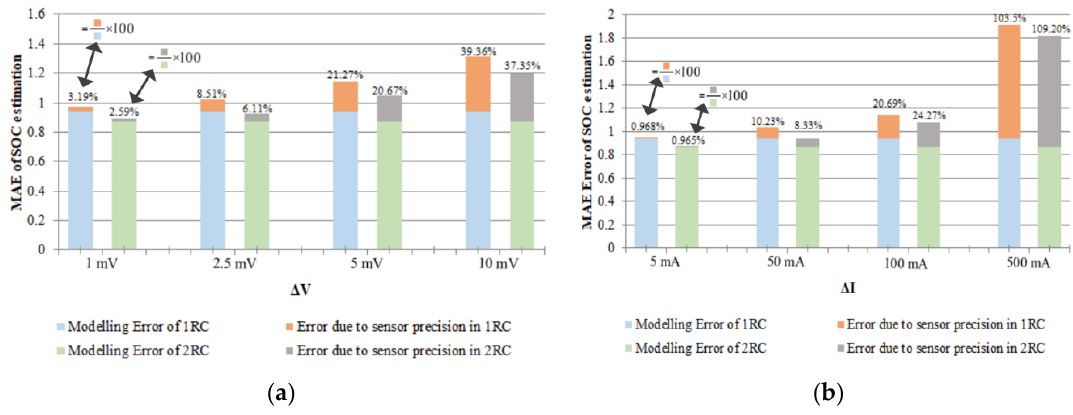
Figure 10. Comparison of first and second order ARX battery models; ( a ) At different uncertainties in measured voltage value; ( b ) At different uncertainties in measured current value.